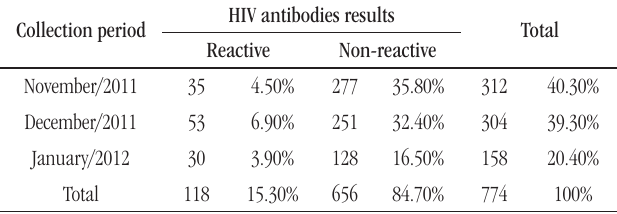
taBLE 1 – Results of HIV antibodies reactivity